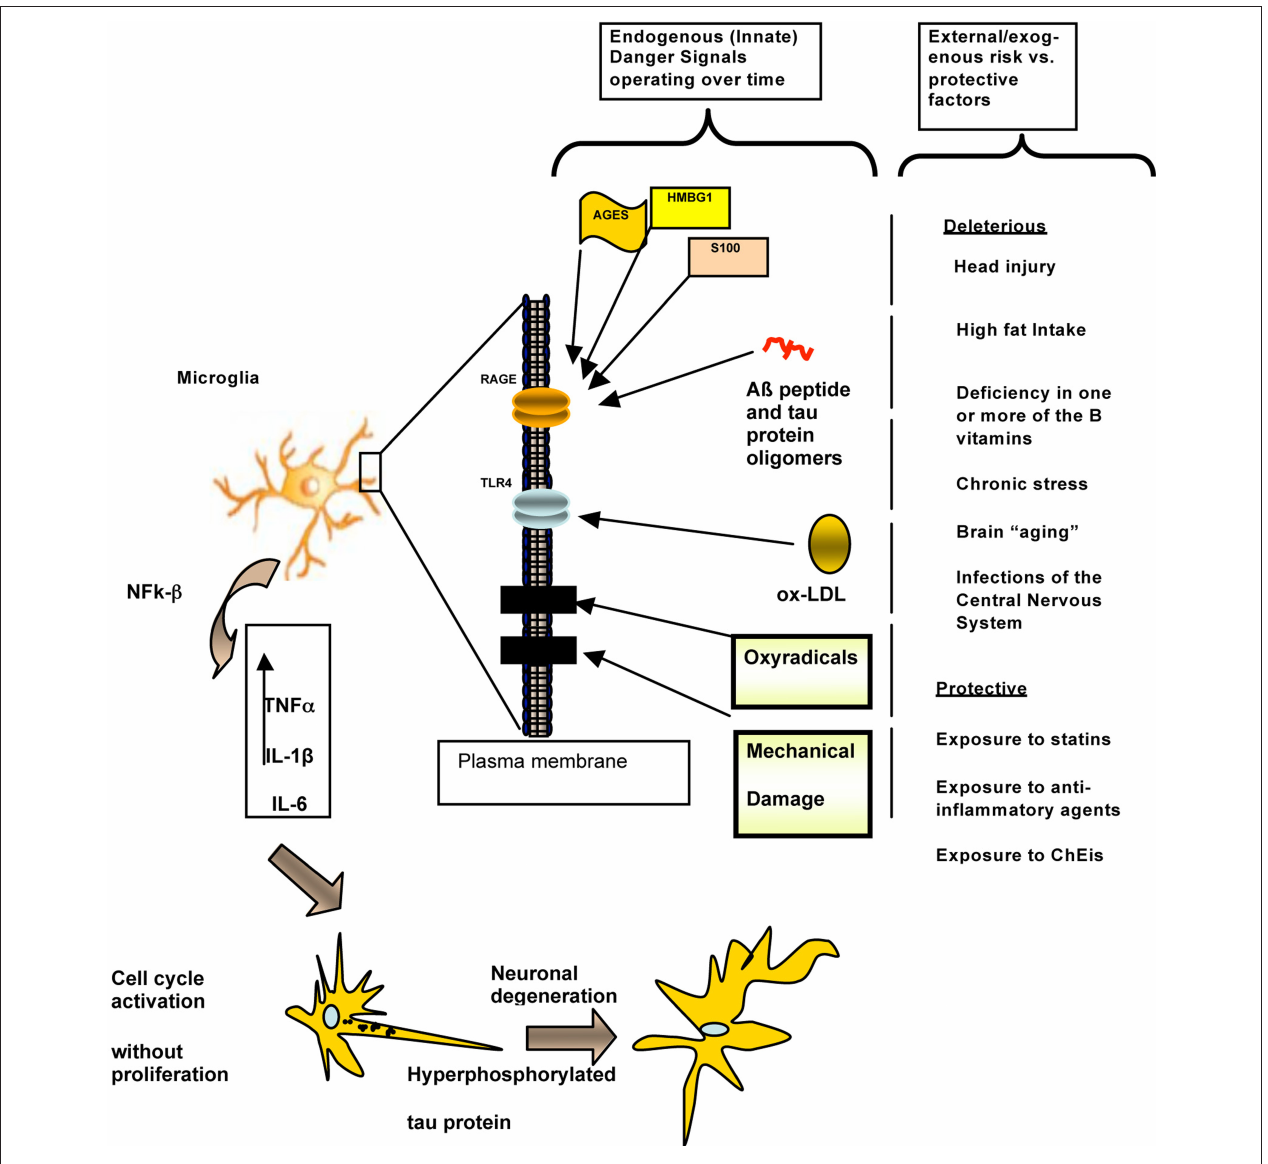
interleukin 1-beta (IL1-ß), and interleukin-six (IL-6). These signals would then mediate neuronal damage directly, reflected in alterations such as tau protein hyperphosphorylation and paired helical filaments formation, which eventually result in neuronal degeneration, Aß peptide aggregation in a beta-pleated configuration, and progressively more severe clinical manifestations of cognitive and behavioral decline unrelated to amyloid aggregation. Modified from Fernández et al. (2008). In this view, converging risk factors (countered by “protective” factors) trigger alterations in the Innate Immune System that converge on RAGE, TLR, and possibly other receptors in the microglial membrane, which in turn trigger well-known events that lead to neuronal degeneration and clinically demonstrable manifestations in AD. While this predominantly molecular-level hypothetical explanation of AD pathogenesis is useful as a framework for the eventual development of “Personalized Medicine” approaches to dementia prevention and treatment, it does not account for the region-, area-, layer, circuit-, and neuron ensemble-specific aspects of AD shown by microscopic analysis ( Figures 2 and 3 ), among many other known levels and scales of involvement ( Figure 1 ). This challenge awaits experimental elucidation to begin to approach the multi-dimensional interpretation we advocate here towards an integrative – and presumably more powerful and far-reaching – understanding of